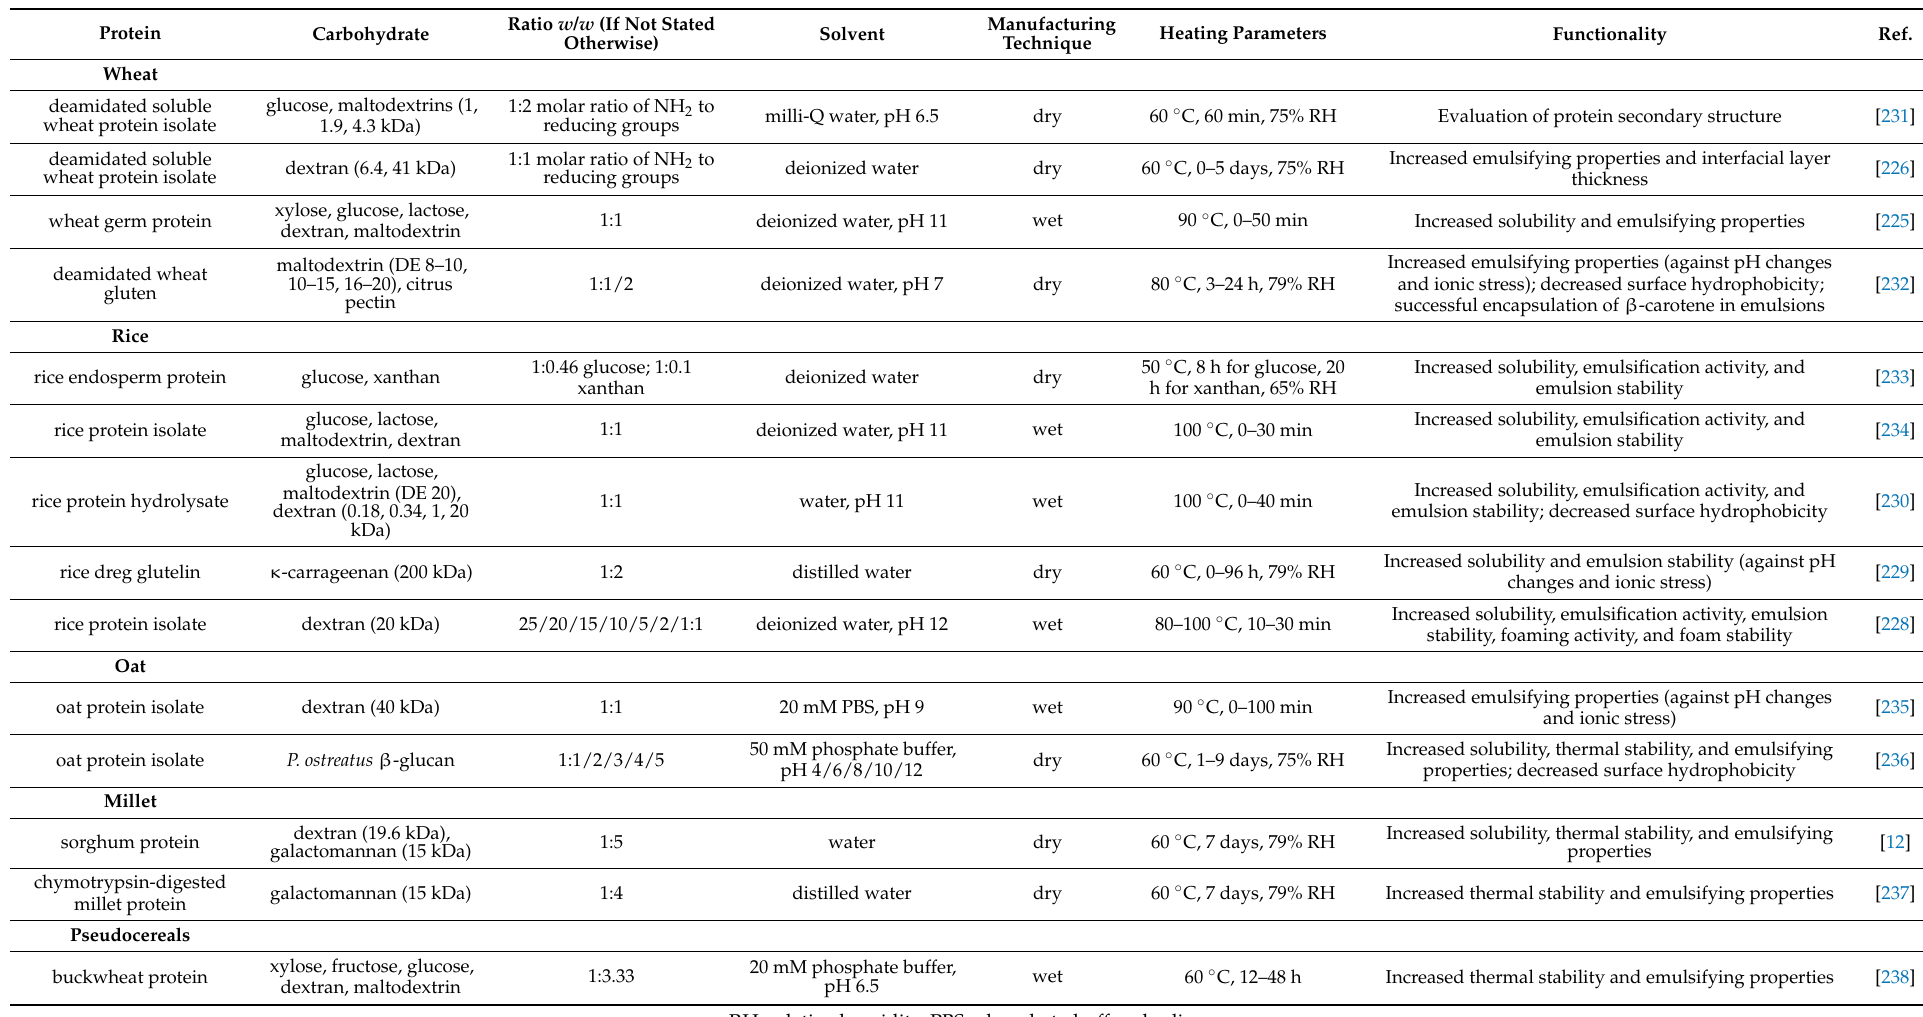
Table 2. Overview on proteins from cereals and pseudocereals glycated with various carbohydrates under different reaction conditions and their functionality. Protein Carbohydrate Ratio w / w (If Not Stated Otherwise) Solvent Manufacturing Technique Heating Parameters Functionality